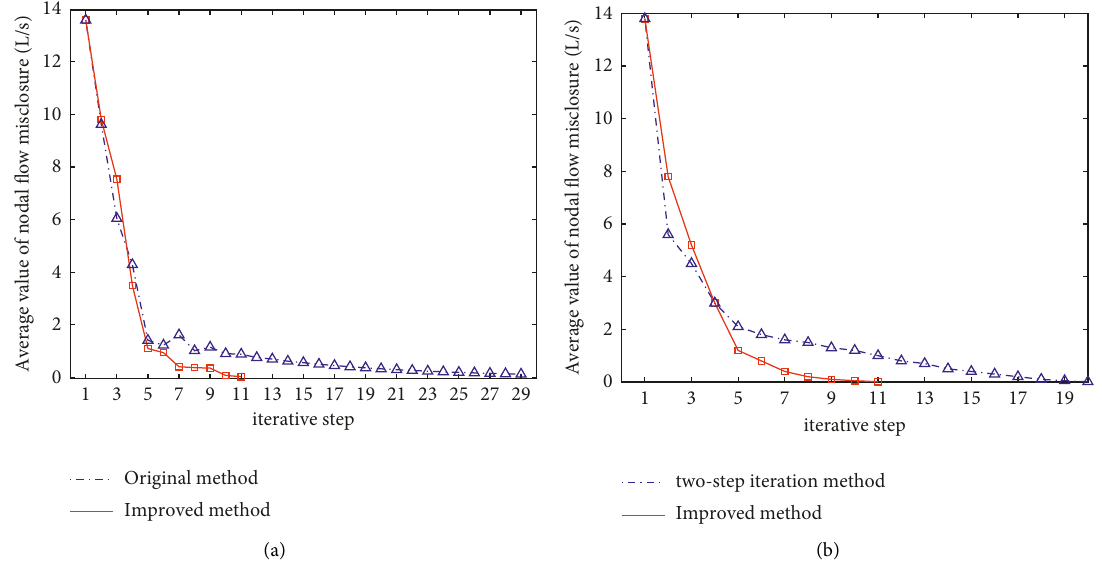
Figure 8: (a) Comparison between the improved hydraulic analysis algorithm in this paper and the original method. (b) Comparison between the improved hydraulic analysis method in this paper and “two-step iteration” low pressure hydraulic analysis method.